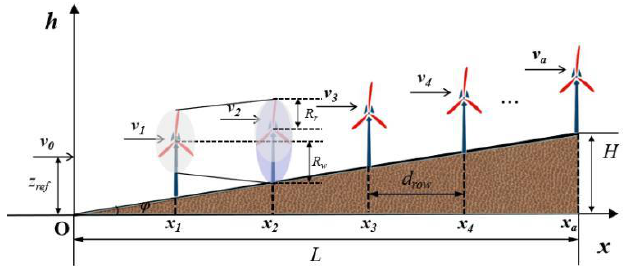
Figure 4. Illustration of WTs’ wake over a hill with gentle gradient.